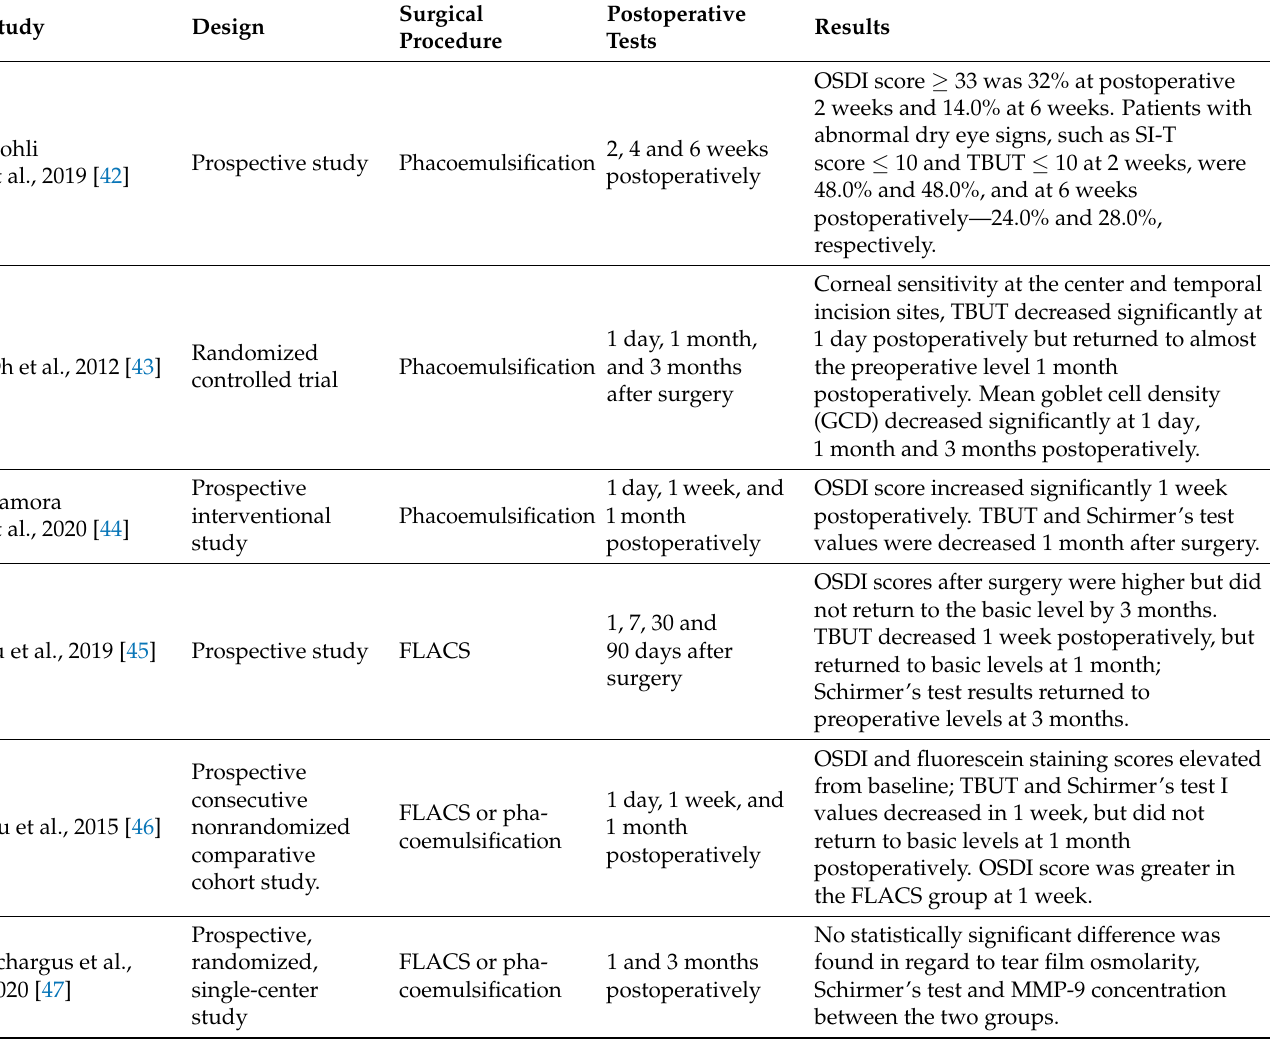
Table 1. Ocular surface dysfunction after cataract